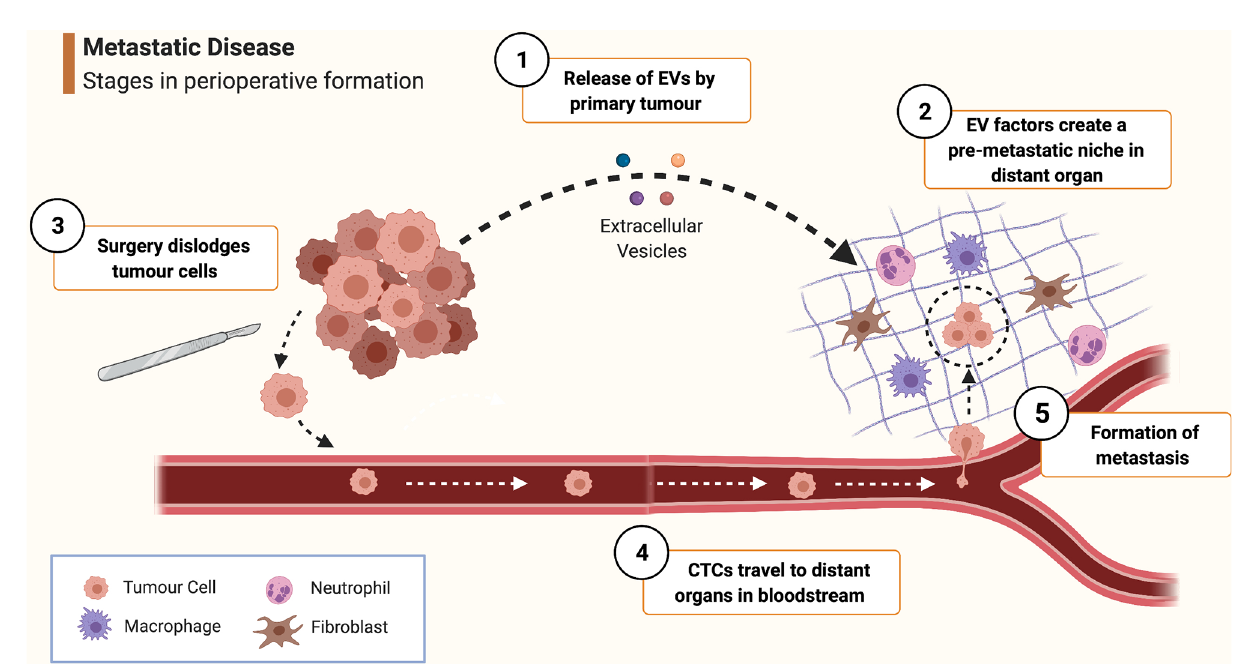
FIGURE 1 | Schematic overview of pathophysiological mechanisms involved in peri-operative metastasis formation. ① As it develops, the primary tumour releases extracellular vesicles (EVs) containing growth factors, miRNAs etc. ② EV-contained factors create a pre-metastatic niche in distant organs by stimulating local cells such as fi broblasts, macrophages and mesenchymal stem cells to promote pro-neoplastic processes such as angiogenesis, in fl ammation and stromal remodelling. ③ During surgery, malignant cells are dispersed from the primary tumour and are released into the bloodstream to form circulating tumour cells (CTCs). ④ CTC are borne in the circulation to distant tissue beds where they arrest and extravasate into a pre-metastatic niche. ⑤ Survival conditions for the tumour cell are rendered even more favourable by the effects of mediators of the surgical stress response and in fl ammation, furthering the processes of angiogenesis, immune evasion etc. thus enabling the cancer cell to survive and proliferate and eventually form a clinically signi fi cant metastasis. (Created with BioRender ®